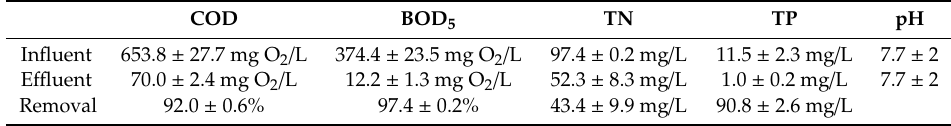
Table 2. Physicochemical characteristics of the influent wastewater (Inf) and effluent water (Eff) in the Los Vados WWTP. Data were provided by the municipal wastewater company of Granada (Emasagra